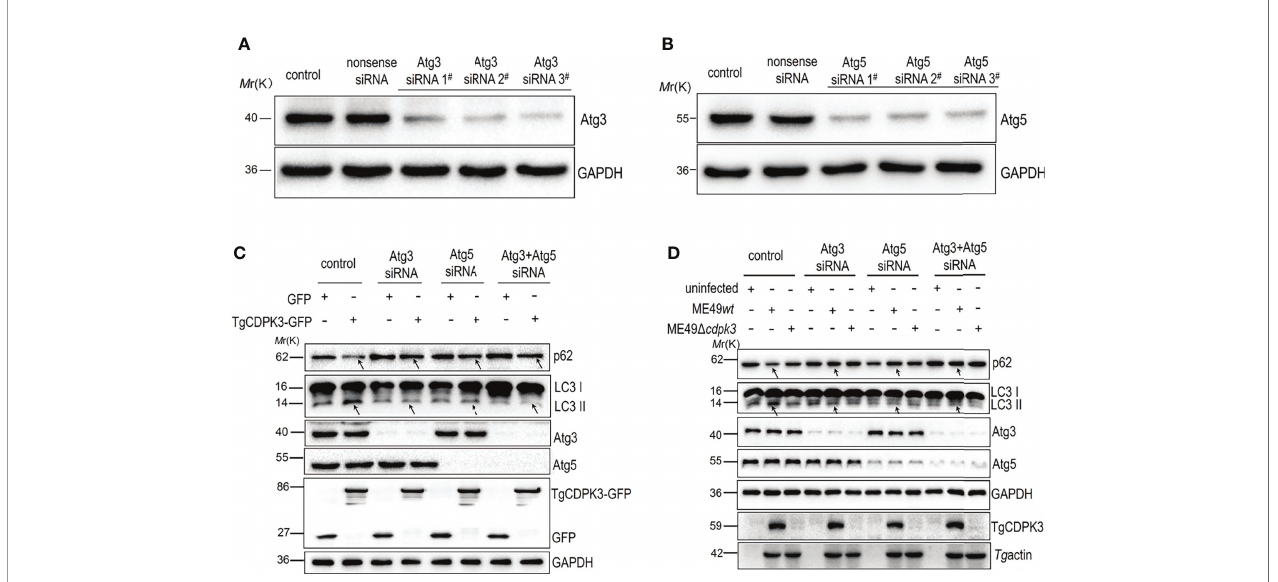
FIGURE 5 | The interference of Atg3 and Atg5 using siRNA down-regulated host cell autophagy induced by Tg CDPK3. (A-B) Western blot con fi rmed that Atg3 and Atg5 were successfully interfered. GAPDH was used as a loading control. (C) Western blotting analyzed the in fl uence of Atg3 or Atg5 blockage on the expression levels of autophagy proteins LC3II and p62 in CDPK3 overexpressing cells. GAPDH was used as a loading control. (D) Western blotting analyzed the in fl uence of Atg3 or Atg5 interference on the expression levels of autophagy proteins LC3II and p62 in cells infected with ME49 wt and ME49 D cdpk3 parasites. GAPDH was used as a loading control. Tg pro fi lin serves as a control for Toxoplasma equivalent loading. The arrow indicates that Atg3 knockdown, Atg5 knockdown, and Atg3 and Atg5 knockdown together signi fi cantly inhibited the expression of LC3-II and increased p62